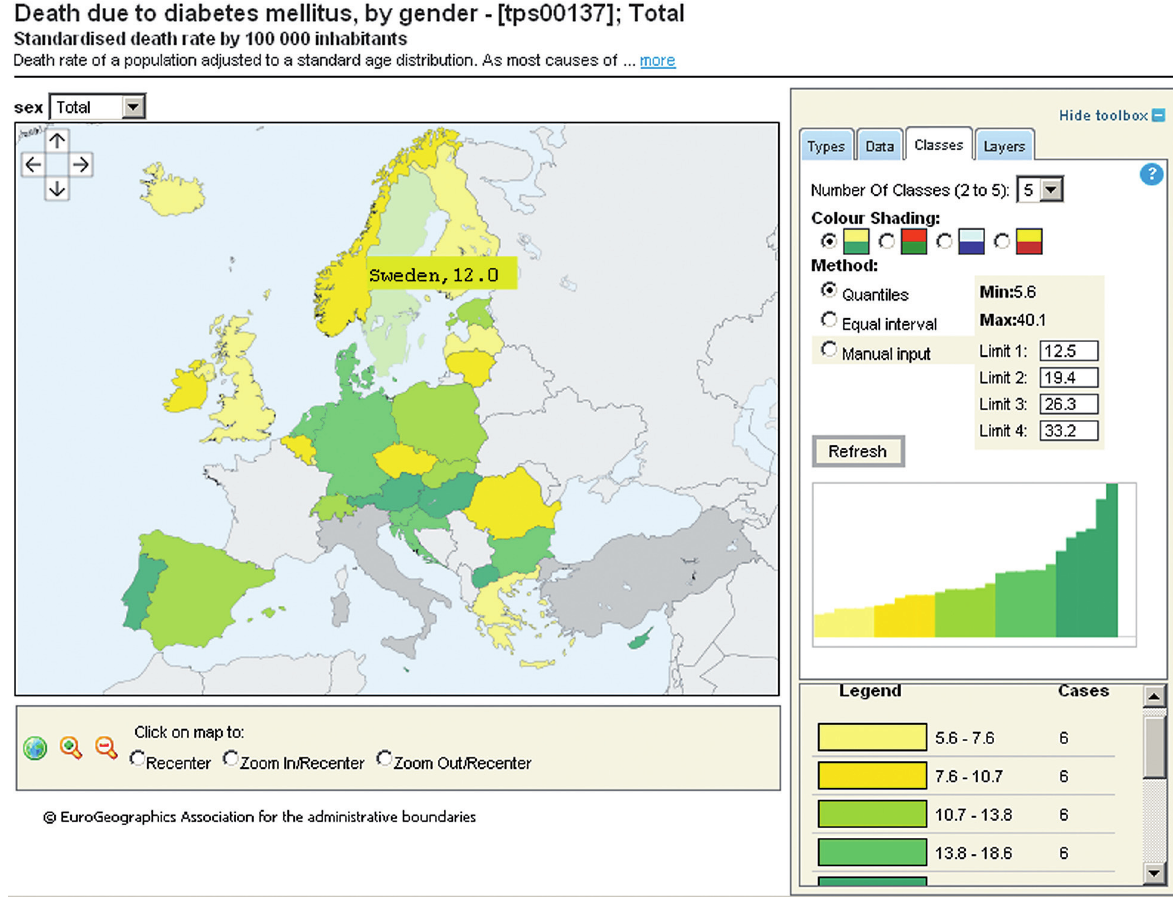
Fig. 6. Death due to diabetes mellitus per 100,000 inhabitants in 2005 visualized by choropleth map (Eurostat